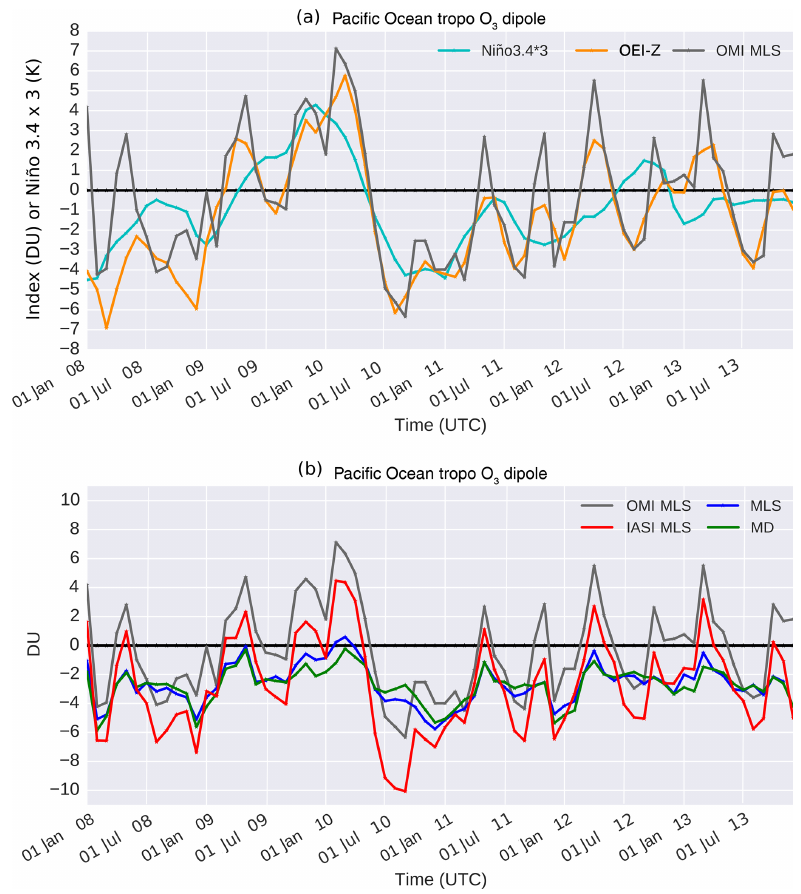
Figure 7. (a) Monthly mean tropospheric Ozone ENSO Index (in DU) derived from the OMI-MLS data (grey line). Also shown is the Niño 3.4 monthly temperature anomaly ENSO index (cyan curve, multiplied by a factor of 3, in Kelvin) and the OEI-Z index derived from the OMI-MLS data with a deseasonalization followed by a sliding average of 3 months (orange curve). (b) The OMI-MLS data (grey curve) as in the above plot, the MLS-a (in blue curve), the DM in green curve and the IASI-a (in red curve). All ENSO indices extend from January 2008 through December